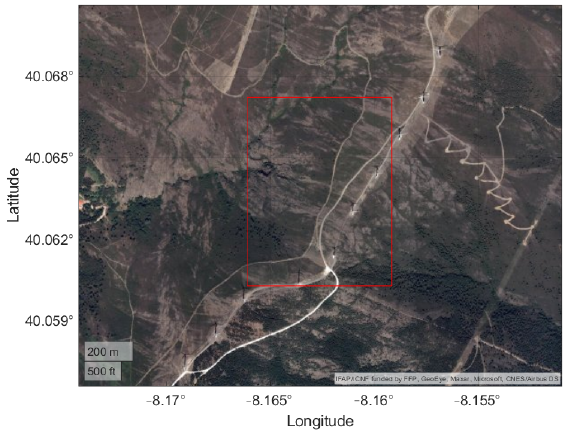
Figure 3. Satellite view of the testing area near Coentral, Leiria